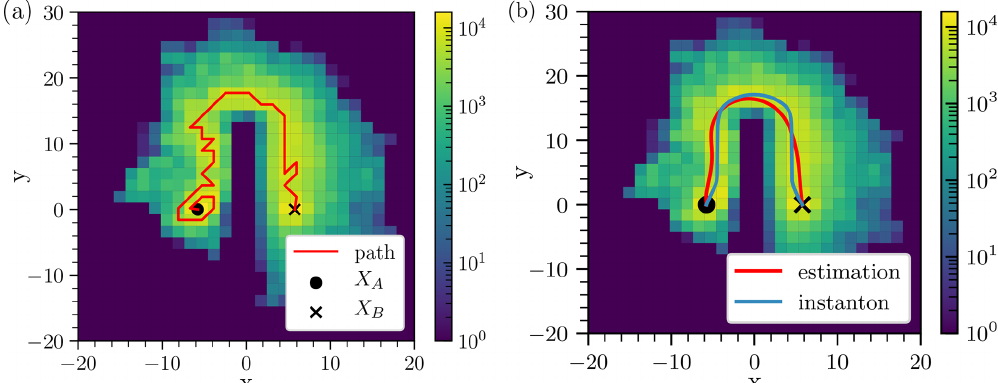
Figure 6. (a) Histogram of N = 300 transition paths at noise level σ = 3, using the modified score function (cid:101) φ gauss with β = 1 . 5, defined by Eq. (6) and implemented with Eq. (14). The corresponding transition probability ( p = 2 × 10 − 3 ) is high enough so that direct Monte Carlo sampling could have been used to produce a similar histogram. The bin resolution ( (cid:49)x = 1 . 4, (cid:49)y = 1 . 75) is coarse for illustration purposes. The histogram is used as input in the path-finding algorithm which produces the transition path in red. Grid-scale spiralling occurs near the initial state X A because of the concentric shell structure of the local probability density function given by Eq. (10). (b) Same histogram as panel (a) . The estimated typical transition path (red) has been cleaned up from its grid-scale spiraling and zigzags with the clean-up algorithm and has then been smoothed. It strongly resembles the instanton (blue) which was computed by implementing the geometric action minimum method (Heymann and Vanden-Eijnden, 2008).